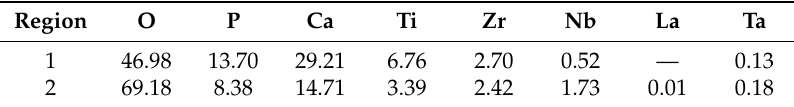
Table 1. The EDS results (at %) for regions 1 and 2 in Figure